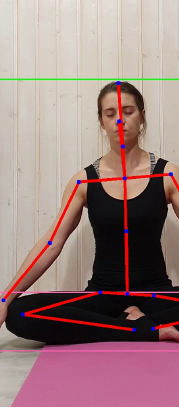
Figure 1. The block diagram of the proposed meditation practice evaluation method.